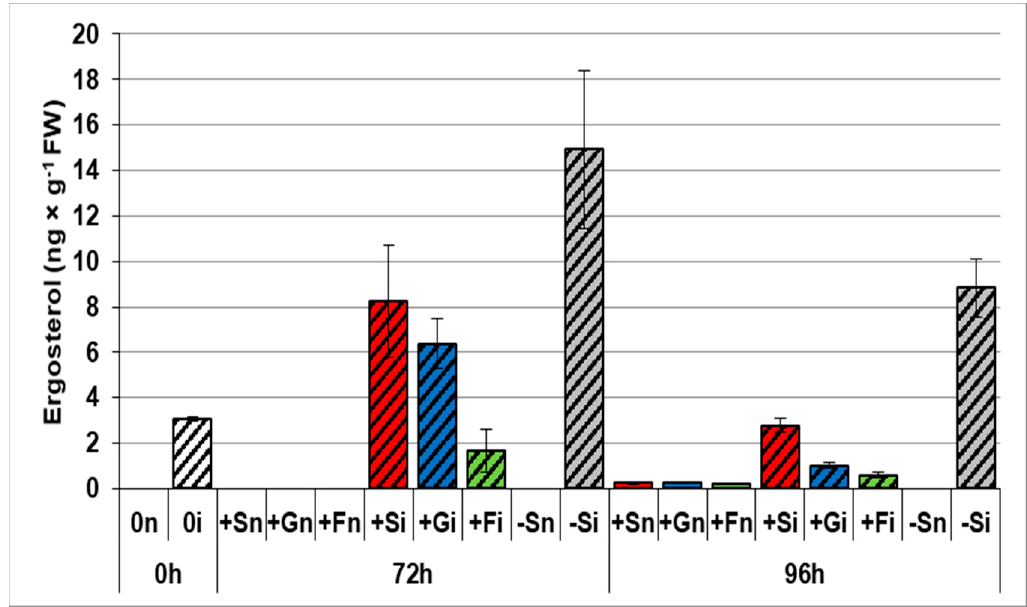
Figure 4. Effects of sucrose, glucose, and fructose on the accumulation of ergosterol in in vitro cultured embryo axes of Lupinus luteus infected with Fusarium oxysporum f. sp. lupini . (+Sn, non-inoculated embryo axes and cultured in vitro on Heller’s medium with 60 mM sucrose; +Gn, non-inoculated embryo axes and cultured in vitro on Heller’s medium with 120 mM glucose; +Fn , non-inoculated embryo axes and cultured in vitro on Heller’s medium with 120 mM fructose; − Sn, non-inoculated embryo axes and cultured in vitro on medium without sucrose; +Si, inoculated and cultured with 60 mM sucrose; +Gi, inoculated and cultured with 120 mM glucose; +Fi, and with 120 mM fructose; − Si, inoculated and cultured without sucrose). A summary of the statistical significance of differences between the average values of each pair at p < 0.05 can be found in the Supplementary Files (Table S3).